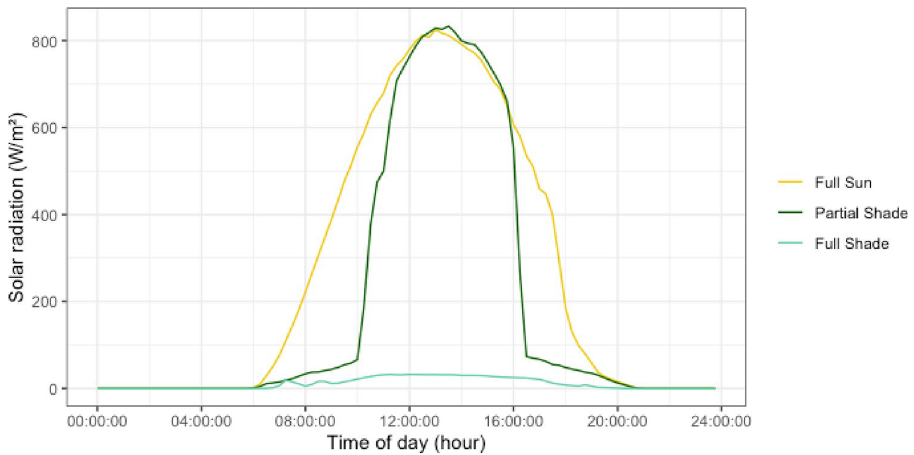
Figure 3. Average daily flux in solar radiation across the agrivoltaic system. Indicated by different color, for three treatments: full sun, partial shade and full